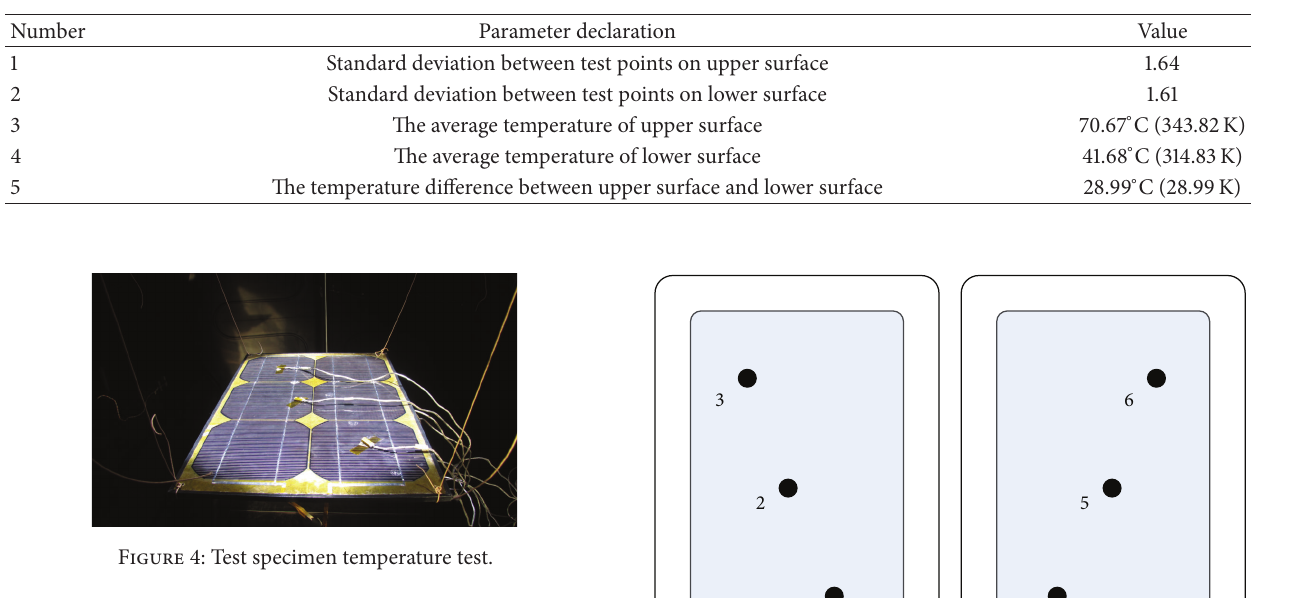
Table 3: Test specimens’ surface average temperature and temperature difference.